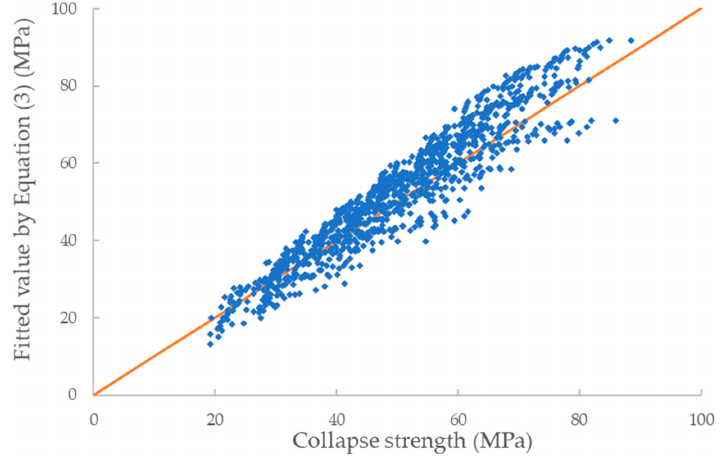
Figure 7. Comparison between the results obtained by using the fitted equation and from the calculation.